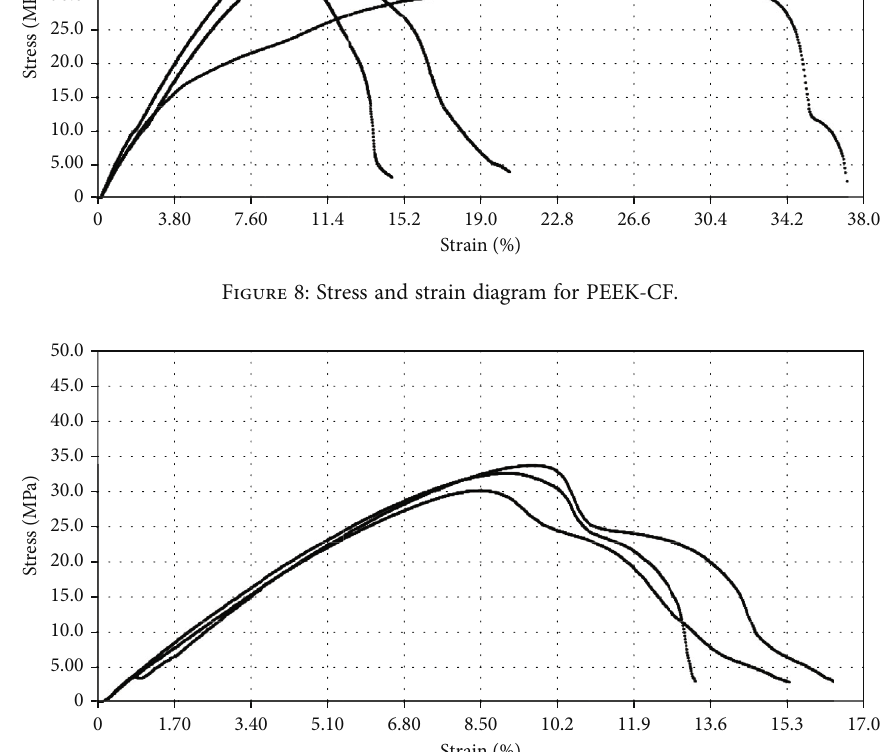
Figure 9: Stress and strain diagram for PETG-CF.